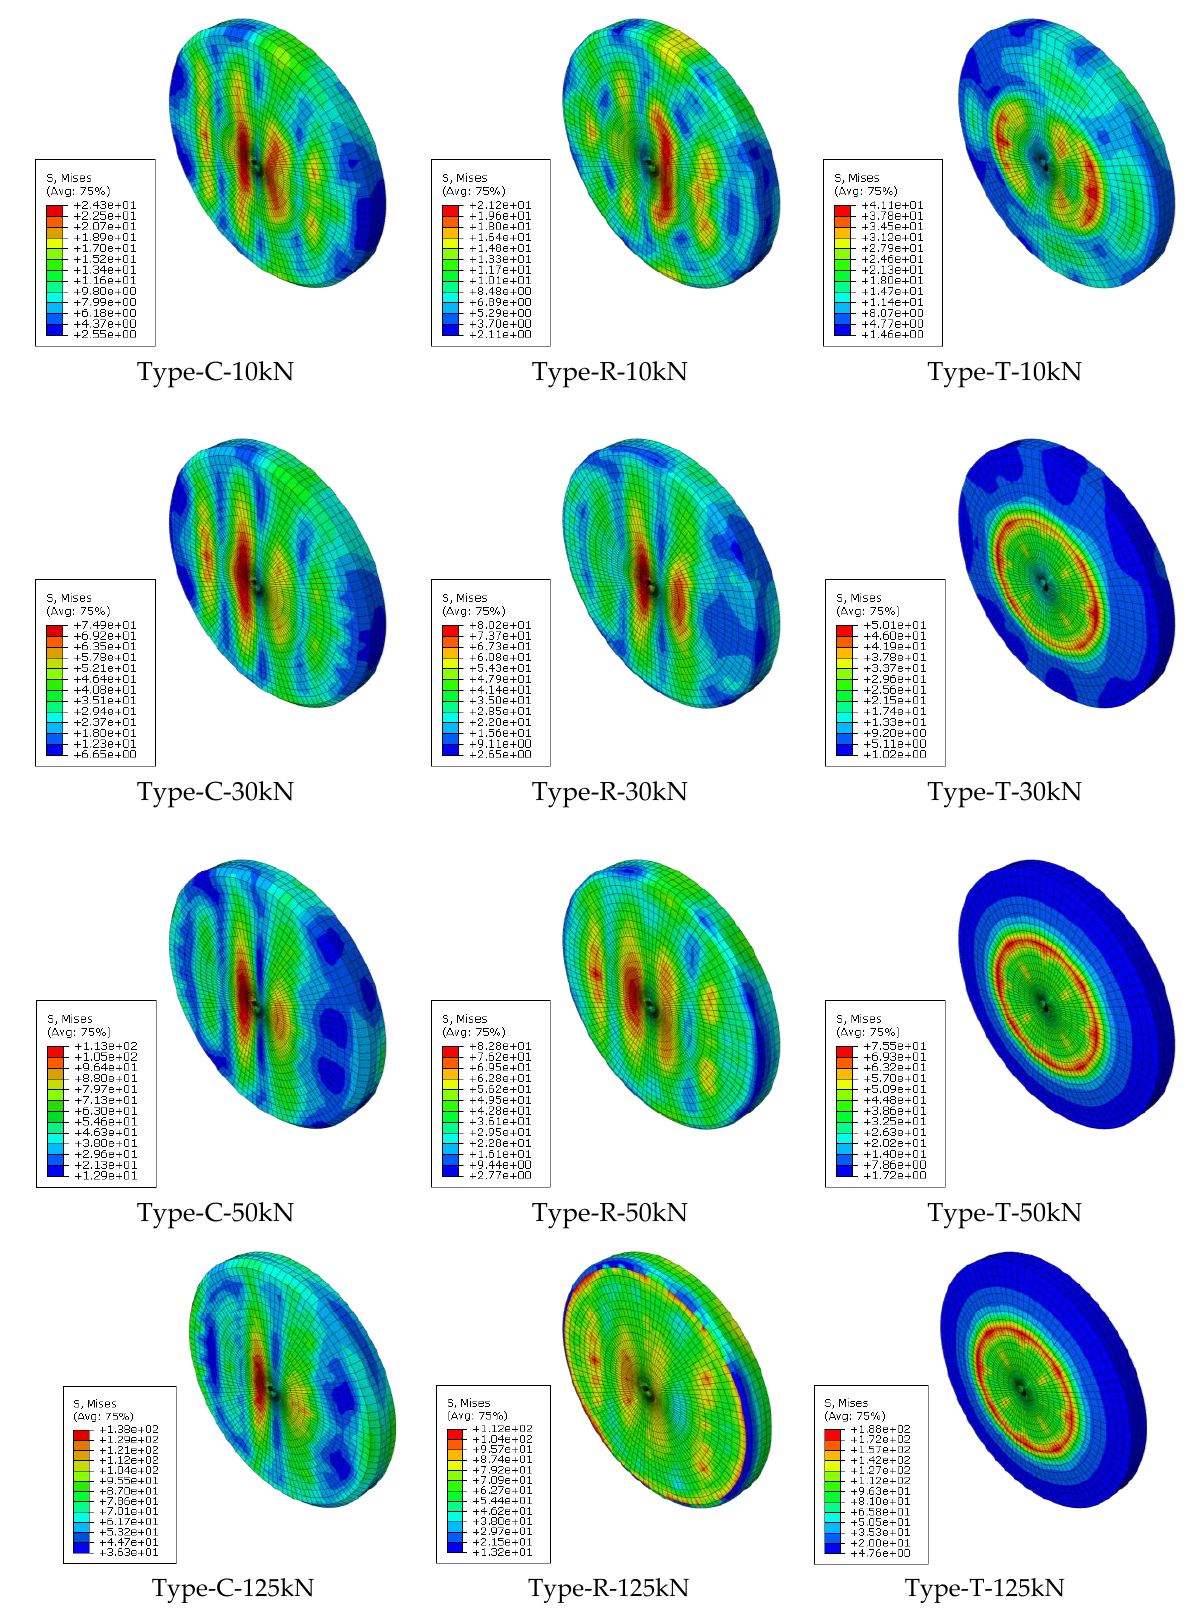
Figure 14. Stress distribution for each ceramic friction material type.